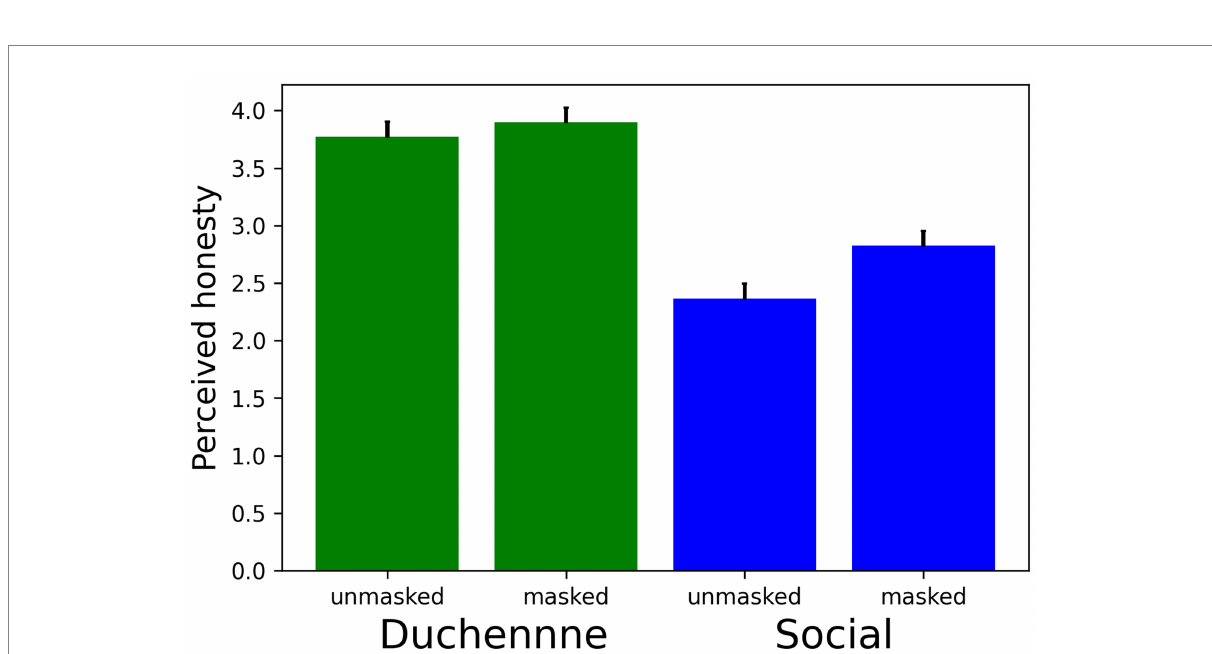
FIGURE 2 Mean honesty ratings for unmasked and masked smiles separately for an honest (Duchenne) and a dishonest (social) smile. Error bars indicate the 95% confidence